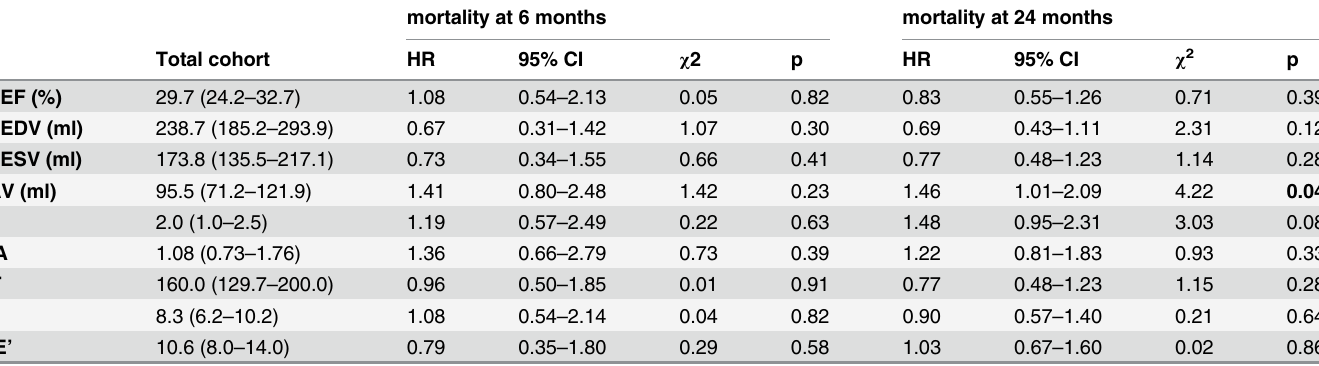
Table 2. Left ventricular dimensions and function before CRT implantation and univariate Cox regression analysis in case of mortality at 6 and 24 months. mortality at 6 months mortality at 24